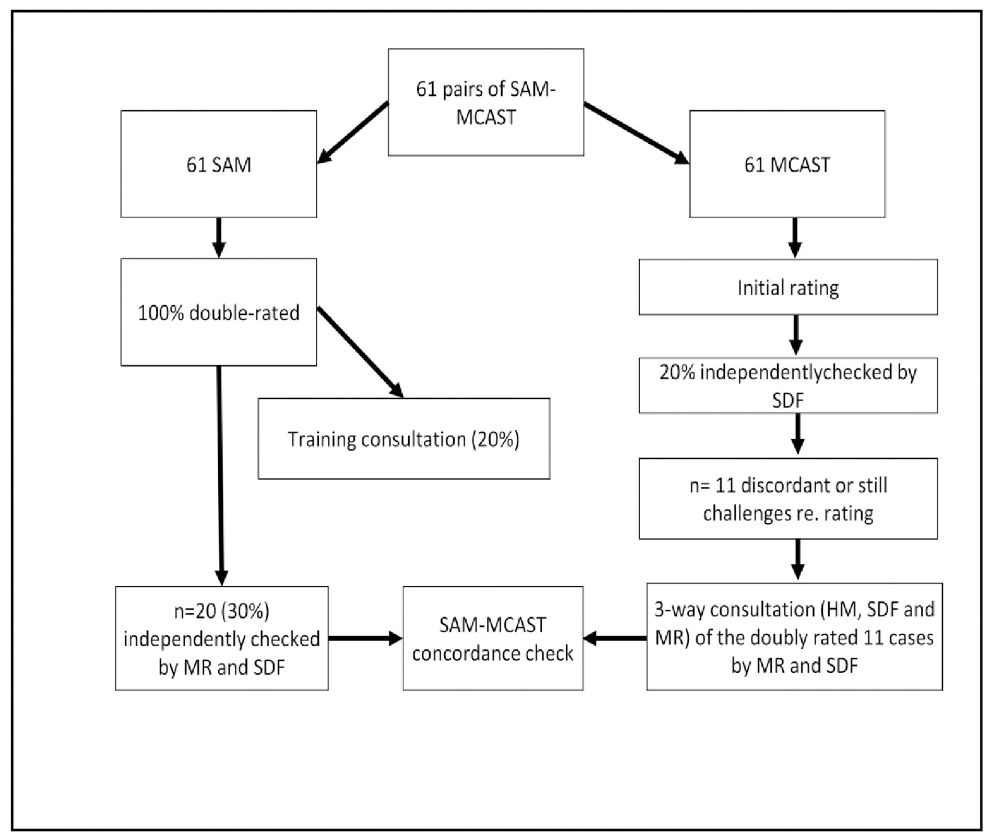
Fig 3. Phase 1 rating and resolution process including role of expert